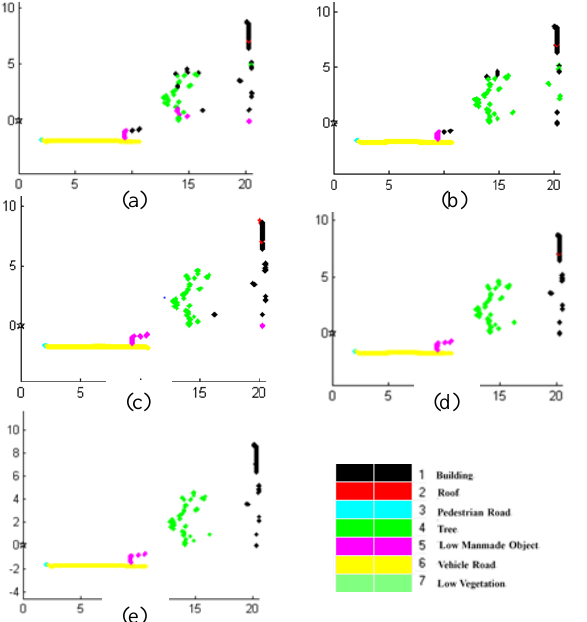
Figure 7. Per-line classification results of Site B: (a) GMM-EM classifier, (b) srCRF, (c) lrCRF, (d) maCRF and (e) ground truth.